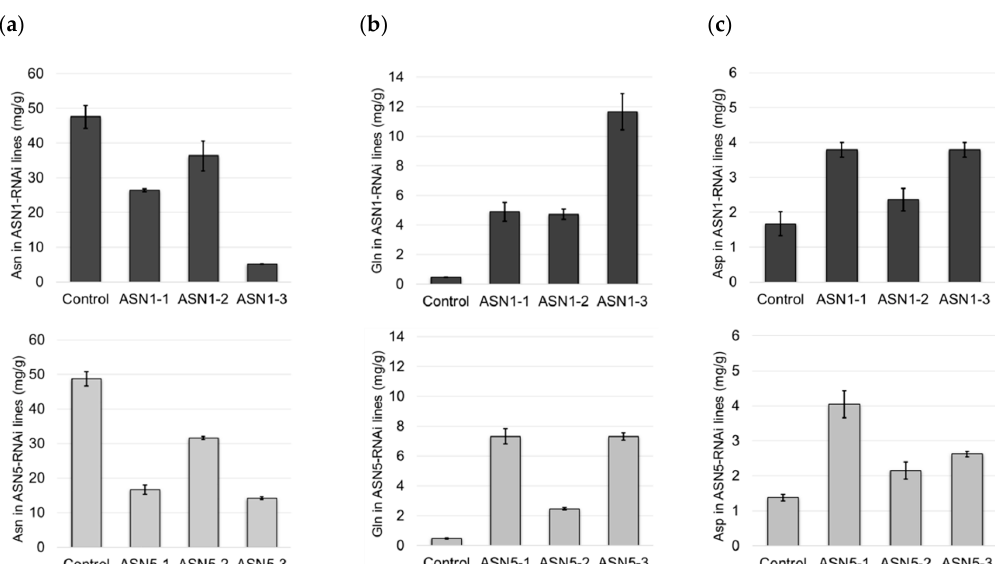
Figure 6. Asparagine, glutamine, and aspartate content in middle leaf lamina of wild-type, ASN1-RNAi , and ASN5-RNAi tobacco plants at the end of detached leaf curing. ( a ) Asparagine (Asn), ( b ) Glutamine (Gln), and ( c ) Aspartic acid (Asp) levels were measured in bulk leaves from 15 T1 transformed burley plants. Data were determined from experiments on three independent transformation events. The data are summarized in histogram bars, in which each bar signifies the amino acid content in mg / g dry weight, and the error bar represents the standard deviation